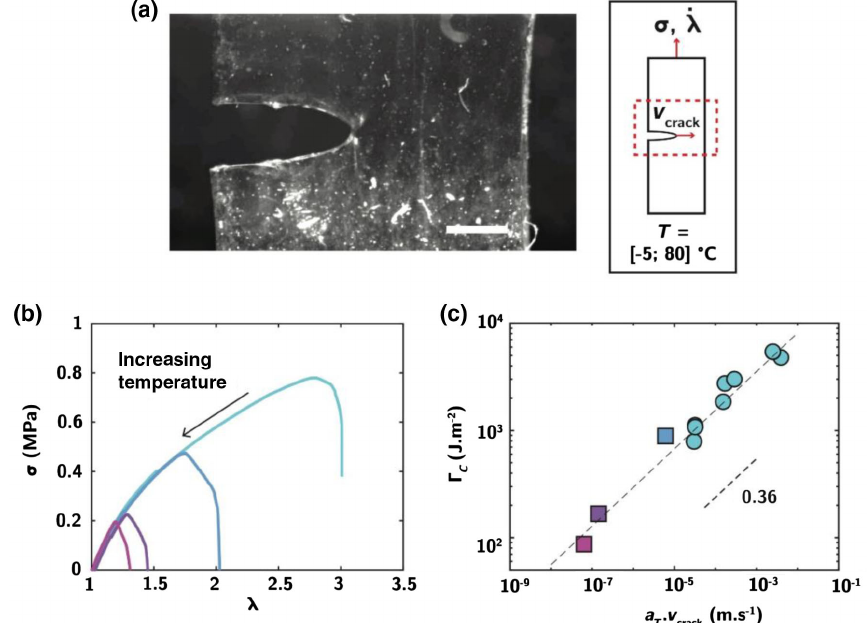
FIG. 1. Macroscopic fracture propagation in elastomers. (a) Image of a notched sample during a fracture test. The scale bar is 1 mm. Inset: Geometry of the fracture test, with a notched sample in uniaxial extension submitted with a constant stretch rate stress σ until a crack propagates at speed v . (b) Stress-strain curves for notched PMA-DA-0.4 elastomer samples at temperature crack T ¼ 25 , 40, 60, and 80 °C (from light blue to purple). (c) Variation of the fracture energy Γ a :v . Squares correspond to samples fractured at different temperatures and constant stretch rate T crack